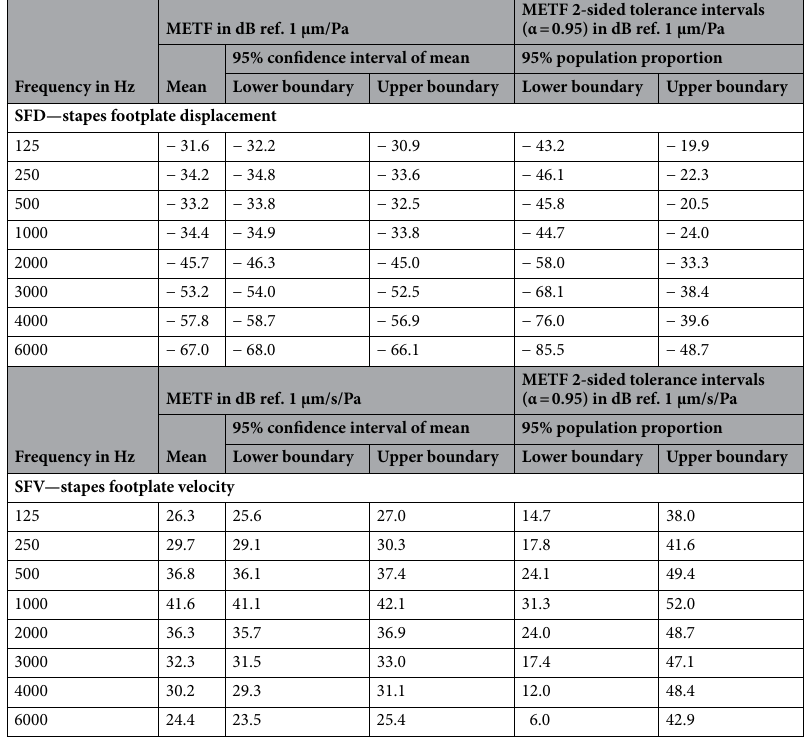
Table 2. Numerical values of METF tolerance interval ranges. All values are given as displacement (upper panel) and velocity (lower panel). Please refer to the supplementary material for a comma-separated spreadsheet version of this